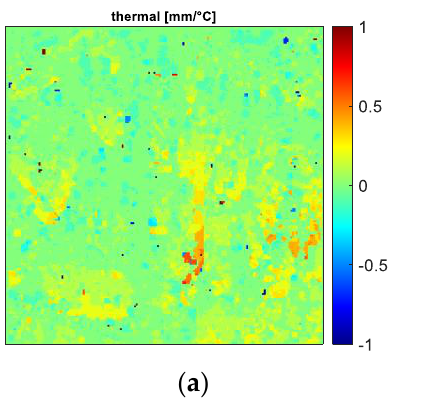
( c ) Figure 10. Jolly Hotel test site: ( a ) points detected using MGLRT with a 3 × 3 patch, positioned in the optical 3D image, with a colorization corresponding to the height (m), ( b ) to the linear deformation velocity (mm/year), and ( c ) to the thermal dilation coefficient (mm/°C). 5. Conclusions In this paper, we show that SAR tomography can be a useful technique for civil struc- ture health monitoring. A stack of SAR images of the structure under monitoring acquired during the observation period are needed, but the cost would be significantly lower than that of in situ contact sensors and ground investigation. The choice of the sensor depends on the availability of the data, but also on the systems characteristics required, such as